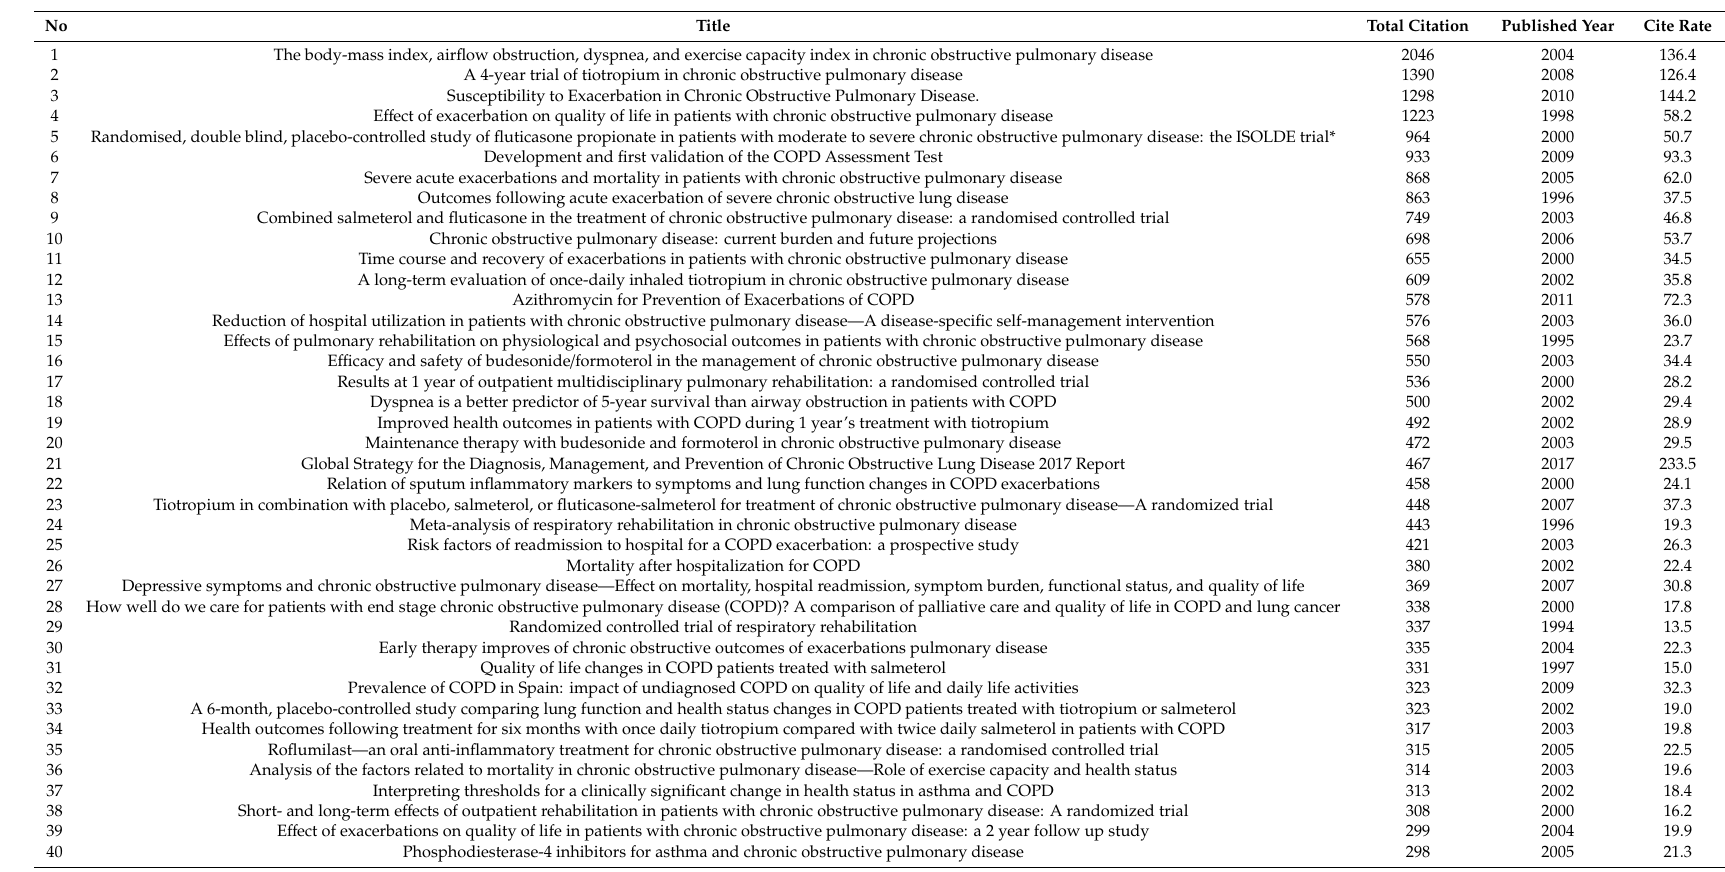
The body-mass index, airflow obstruction, dyspnea, and exercise capacity index in chronic obstructive pulmonary disease 2046 A 4-year trial of tiotropium in chronic obstructive pulmonary disease 1390 2008 126.4 3 Susceptibility to Exacerbation in Chronic Obstructive Pulmonary Disease. 1298 2010 144.2 4 1223 58.2 5 Randomised, double blind, placebo-controlled study of fluticasone propionate in patients with moderate to severe chronic obstructive pulmonary disease: the ISOLDE trial* 964 Development and first validation of the COPD Assessment Test 933 Severe acute exacerbations and mortality in patients with chronic obstructive pulmonary disease 868 Outcomes following acute exacerbation of severe chronic obstructive lung disease 863 Combined salmeterol and fluticasone in the treatment of chronic obstructive pulmonary disease: a randomised controlled trial 749 Chronic obstructive pulmonary disease: current burden and future projections 698 Time course and recovery of exacerbations in patients with chronic obstructive pulmonary disease A long-term evaluation of once-daily inhaled tiotropium in chronic obstructive pulmonary disease Azithromycin for Prevention of Exacerbations of COPD 72.3 14 Reduction of hospital utilization in patients with chronic obstructive pulmonary disease—A disease-specific self-management intervention E ff ects of pulmonary rehabilitation on physiological and psychosocial outcomes in patients with chronic obstructive pulmonary disease 568 E ffi cacy and safety of budesonide / formoterol in the management of chronic obstructive pulmonary disease 550 Results at 1 year of outpatient multidisciplinary pulmonary rehabilitation: a randomised controlled trial Dyspnea is a better predictor of 5-year survival than airway obstruction in patients with COPD 500 Improved health outcomes in patients with COPD during 1 year’s treatment with tiotropium Maintenance therapy with budesonide and formoterol in chronic obstructive pulmonary disease 472 Global Strategy for the Diagnosis, Management, and Prevention of Chronic Obstructive Lung Disease 2017 Report Relation of sputum inflammatory markers to symptoms and lung function changes in COPD exacerbations Tiotropium in combination with placebo, salmeterol, or fluticasone-salmeterol for treatment of chronic obstructive pulmonary disease—A randomized trial 448 Meta-analysis of respiratory rehabilitation in chronic obstructive pulmonary disease Risk factors of readmission to hospital for a COPD exacerbation: a prospective study Mortality after hospitalization for COPD Depressive symptoms and chronic obstructive pulmonary disease—E ff ect on mortality, hospital readmission, symptom burden, functional status, and quality of life 30.8 28 How well do we care for patients with end stage chronic obstructive pulmonary disease (COPD)? A comparison of palliative care and quality of life in COPD and lung cancer Randomized controlled trial of respiratory rehabilitation Early therapy improves of chronic obstructive outcomes of exacerbations pulmonary disease 335 22.3 31 Quality of life changes in COPD patients treated with salmeterol 331 1997 15.0 32 Prevalence of COPD in Spain: impact of undiagnosed COPD on quality of life and daily life activities 323 2009 32.3 33 323 2002 19.0 34 317 Roflumilast—an oral anti-inflammatory treatment for chronic obstructive pulmonary disease: a randomised controlled trial 315 Analysis of the factors related to mortality in chronic obstructive pulmonary disease—Role of exercise capacity and health status 314 2003 19.6 37 Interpreting thresholds for a clinically significant change in health status in asthma and COPD 313 2002 Short- and long-term e ff ects of outpatient rehabilitation in patients with chronic obstructive pulmonary disease: A randomized trial 308 2000 16.2 39 299 2004 Phosphodiesterase-4 inhibitors for asthma and chronic obstructive pulmonary disease 298 2005 21.3 Note: * The inhaled steroids in obstructive lung disease in Europe